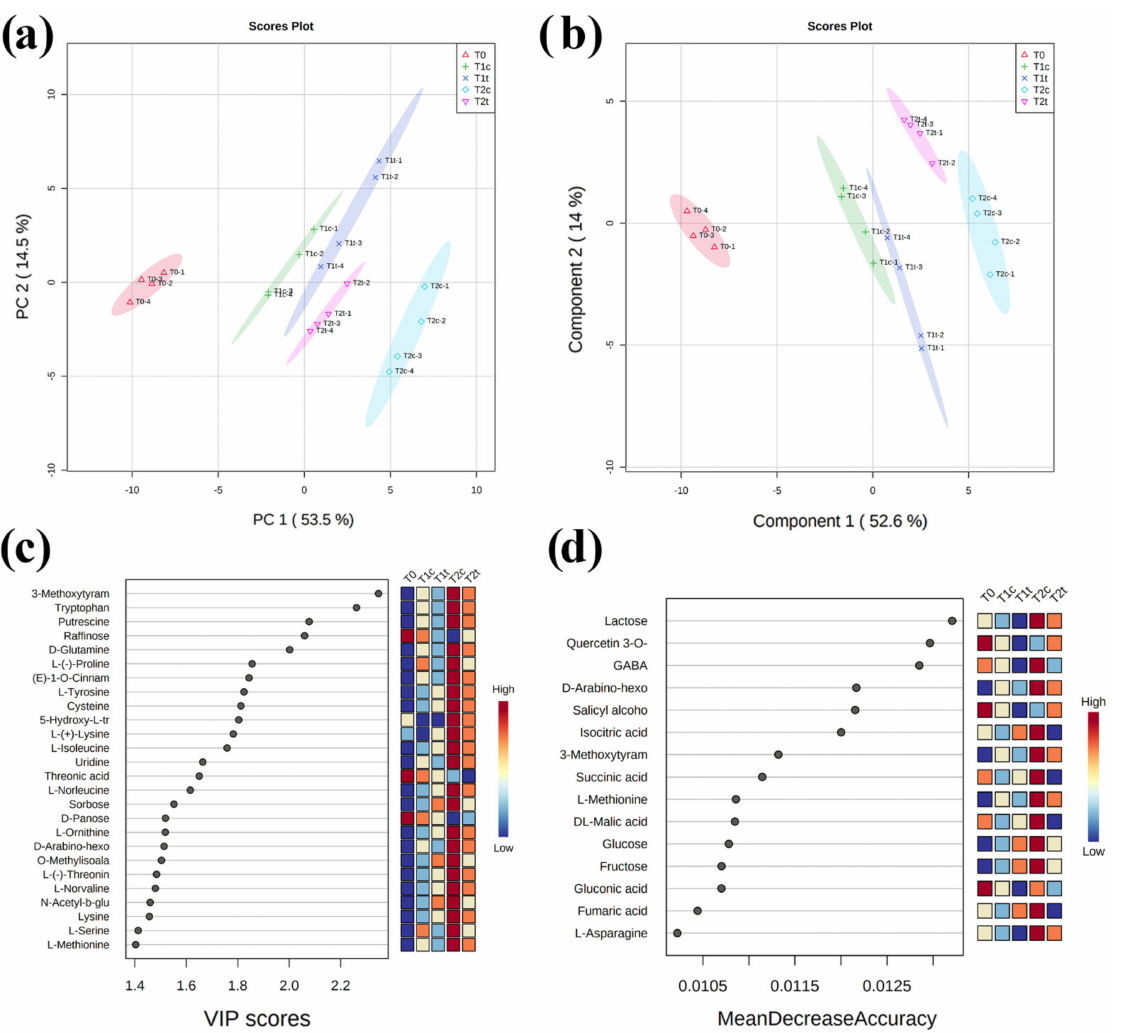
Figure 5. Discrimination through principal component analysis (PCA) and partial least-squares discriminant analysis (PLS-DA) of the metabolites’ patterns in R. sativus seeds exposed for 0 h, 24 h, and 48 h to 0 µ M and 400 µ M of coumarin. T0 (untreated seeds at the beginning of the experiments), T1c (control, 24 h), T2c (control, 48 h), T1t (treated, 24 h), T2t (treated, 48 h). ( a ) PCA and ( b ) PLS- DA showing score plots that allowed groups discrimination by virtue of the first two principal components (PCs). ( c ) Variable importance of projection (VIP) features for the groups from PLS-DA analysis. ( d ) Random forest analysis displaying the mean decrease in accuracies. (N =